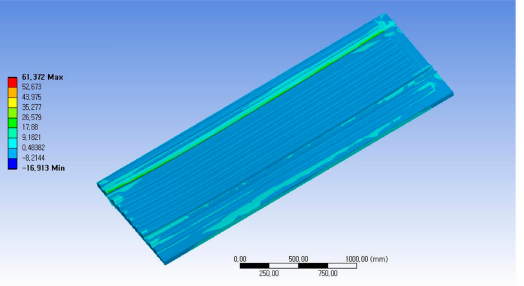
Figure 14. Stress analysis result of load case 2-Maximum principal stress 61.37 MPa.